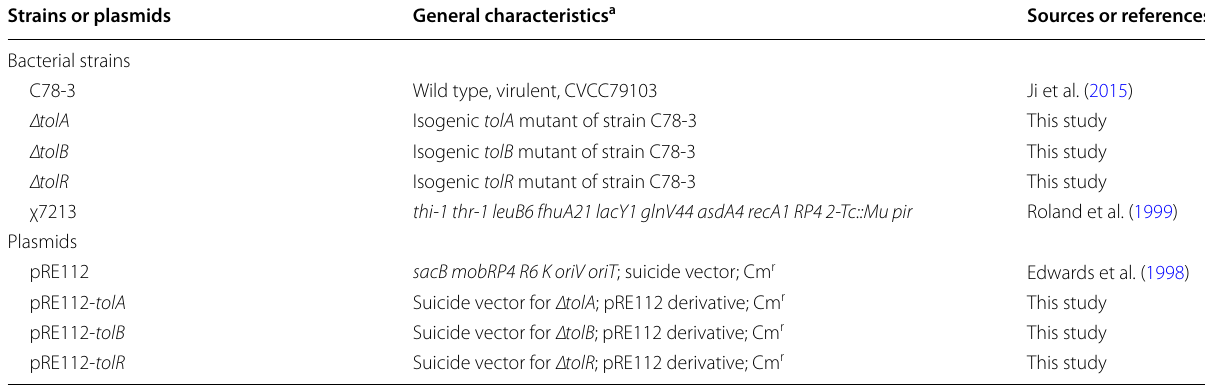
a Cm r : chloramphenicol resistance